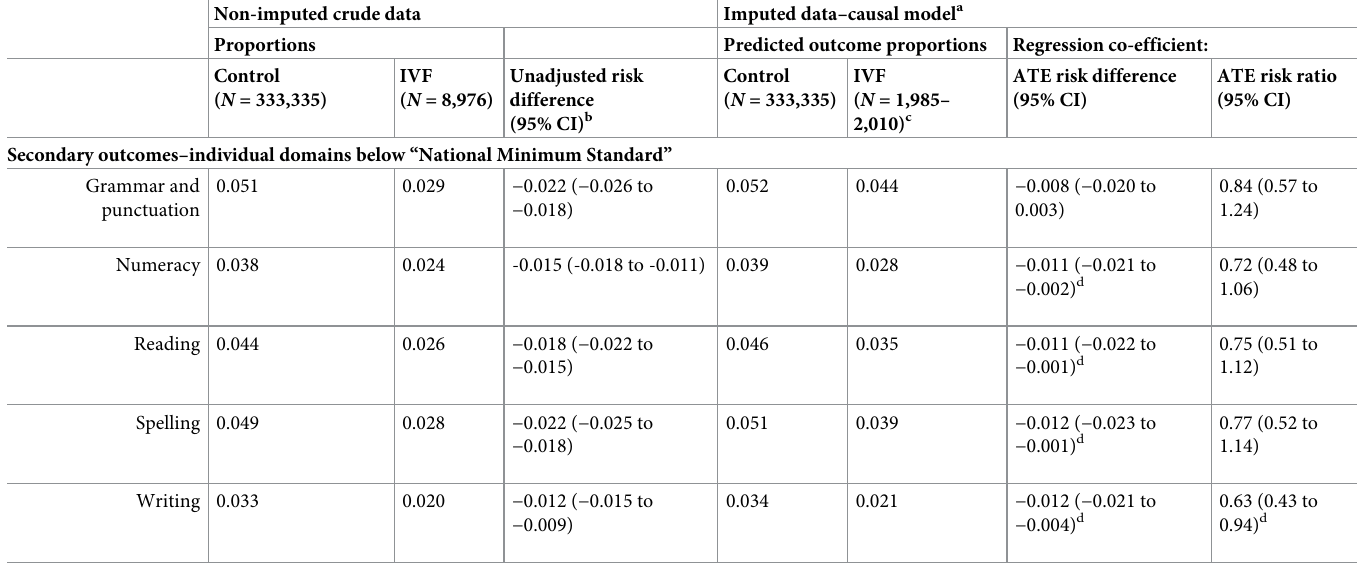
Table 5. Results of final causal